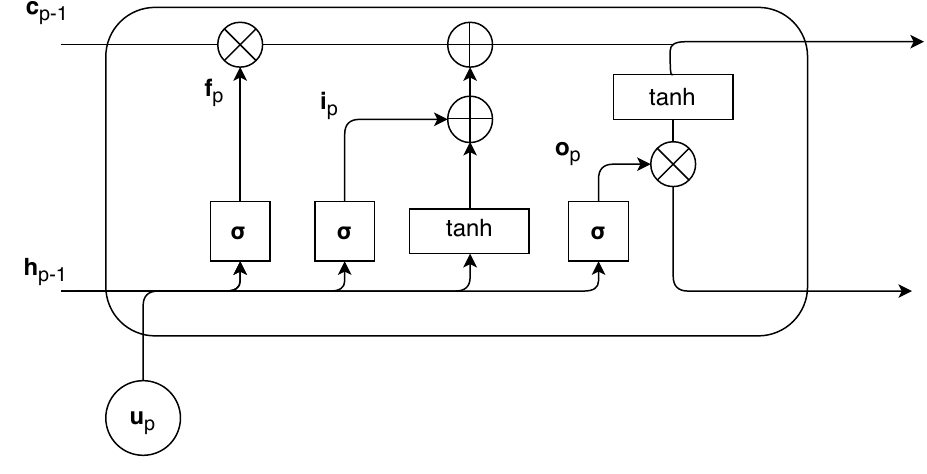
Figure 4. The structure of the